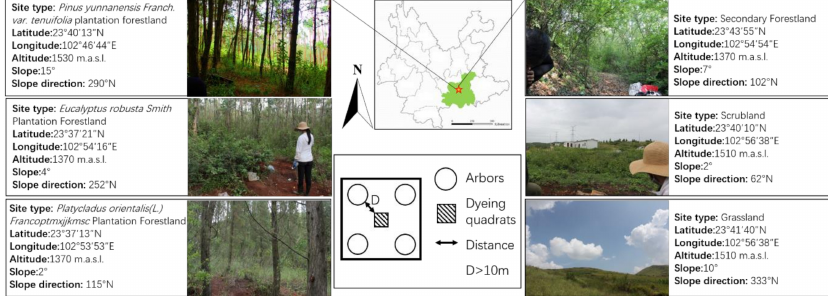
Figure 1. Basic situation of the experimental sites in Yunnan Province,